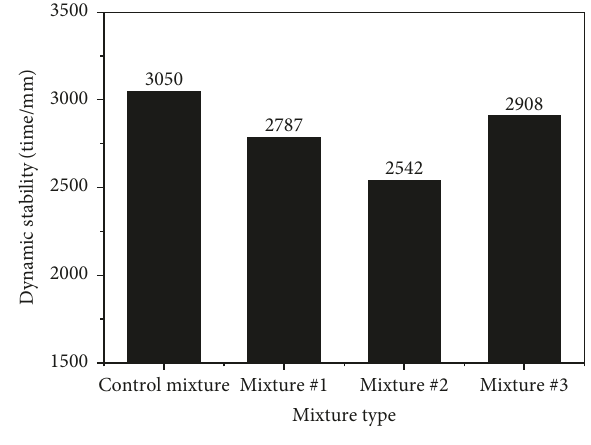
Figure 10: Results of dynamic stability.